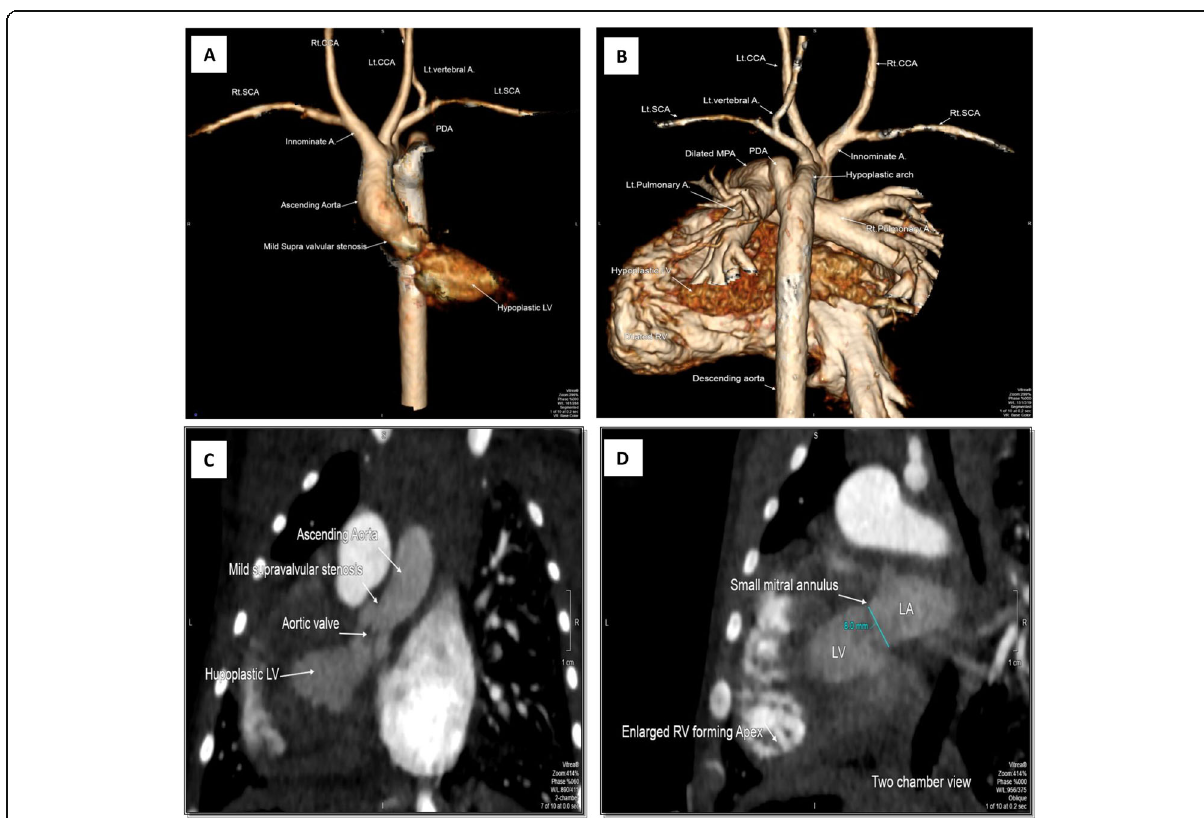
Fig. 4 A case of left hypo plastic heart syndrome with aortic arch hypoplasia aged 9 days presented with failure to thrive. a Volume rendered image of the thoracic aorta and left ventricle showing mild supravalvular stenosis of the aortic root which arises from hypoplastic left ventricle also aortic arch hypoplasia. b Volume rendered image of the heart and great vessels showing a large PDA connecting aorta to pulmonary artery, left ventricular hypoplasia and right ventricular hypertrophy. c LVOT view showing hypoplastic left ventricle with aortic valve thickening with mild supravalvular aortic stenosis. d Two chamber view of the left side of heart showing small mitral